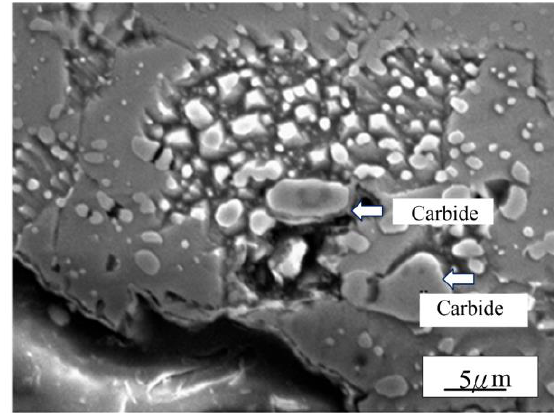
Figure 7. Initial position of crack during cold working.